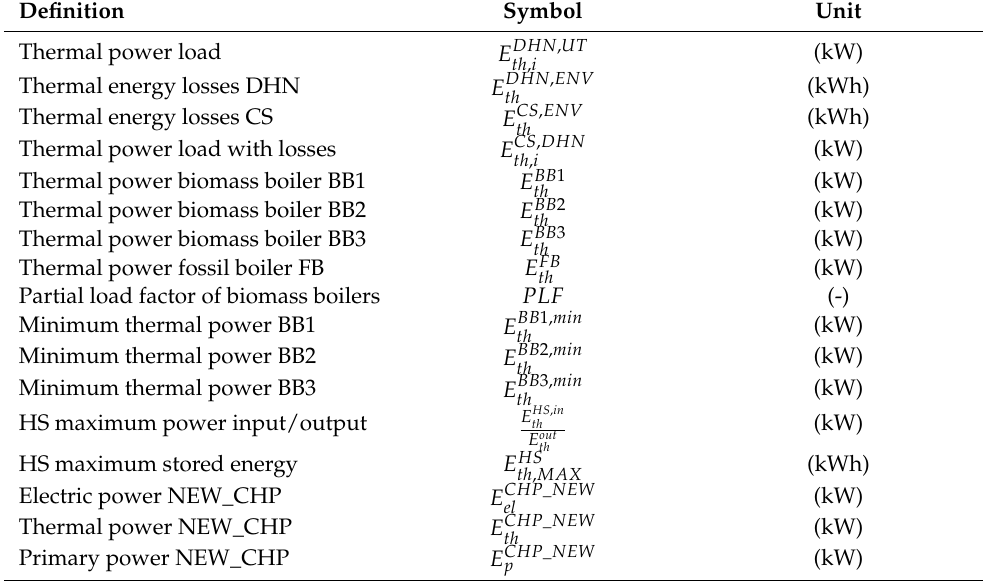
Table 3. Data input parameters.